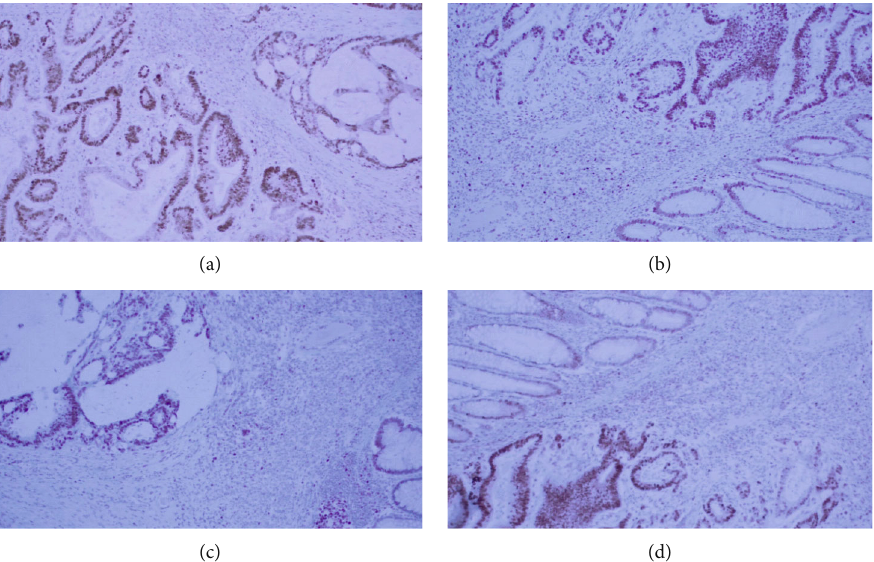
Figure 7: Positive staining of the clear cell component for MMR: (a) PMS2 (100 × ); (b) MSH6 (100 × ); (c) MSH2 (100 × ); (d) MCH1 (100 × ).